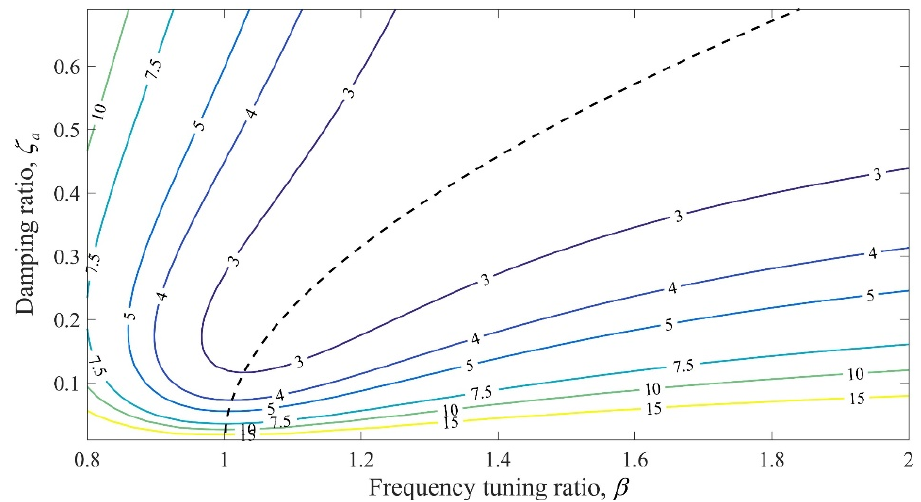
Figure 3. Contour plot of I p superimposed with the solution (black dashed line) of Equation (25) when µ = 0.15.